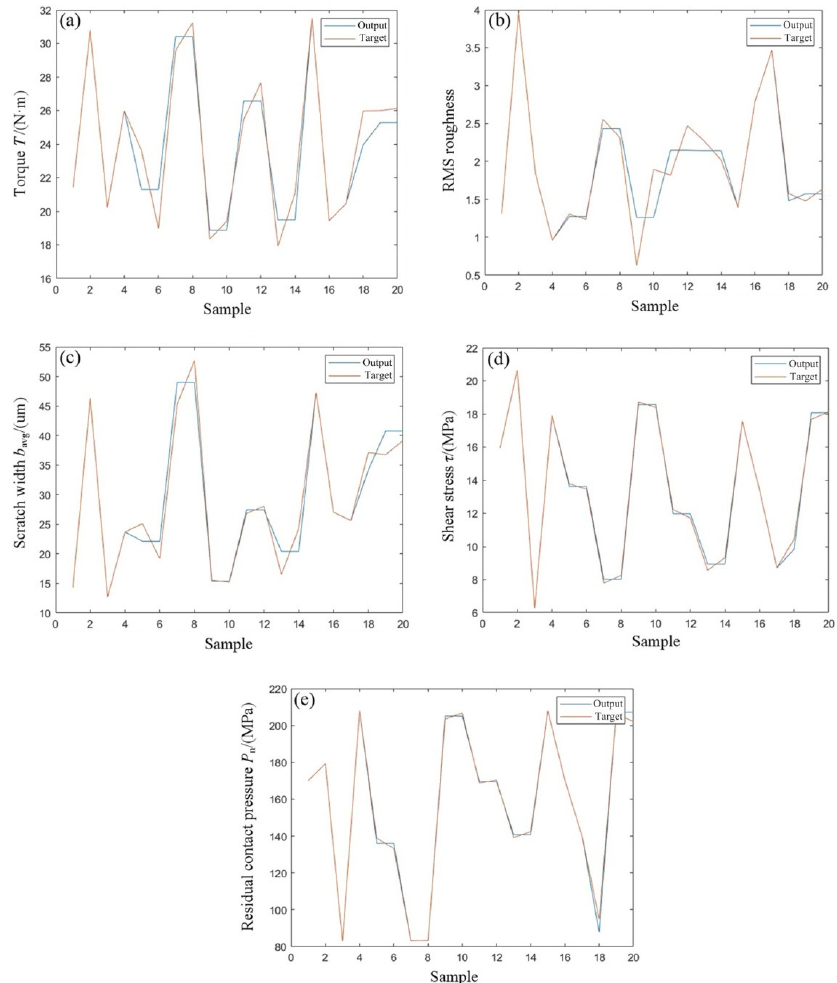
Figure 11. Output and target values of BP neural network: ( a ) torque, ( b ) surface roughness, ( c ) scratch width, ( d ) shear stress and ( e ) residual contact pressure. Table 7. Predicted values and relative errors of three test